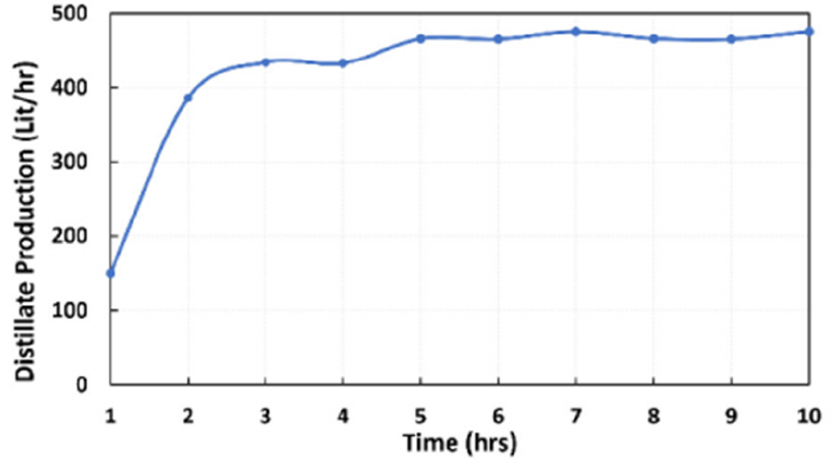
Figure 12. Distillate water production for one cell of a MED facility during 10 operation hours, adapted from [26].